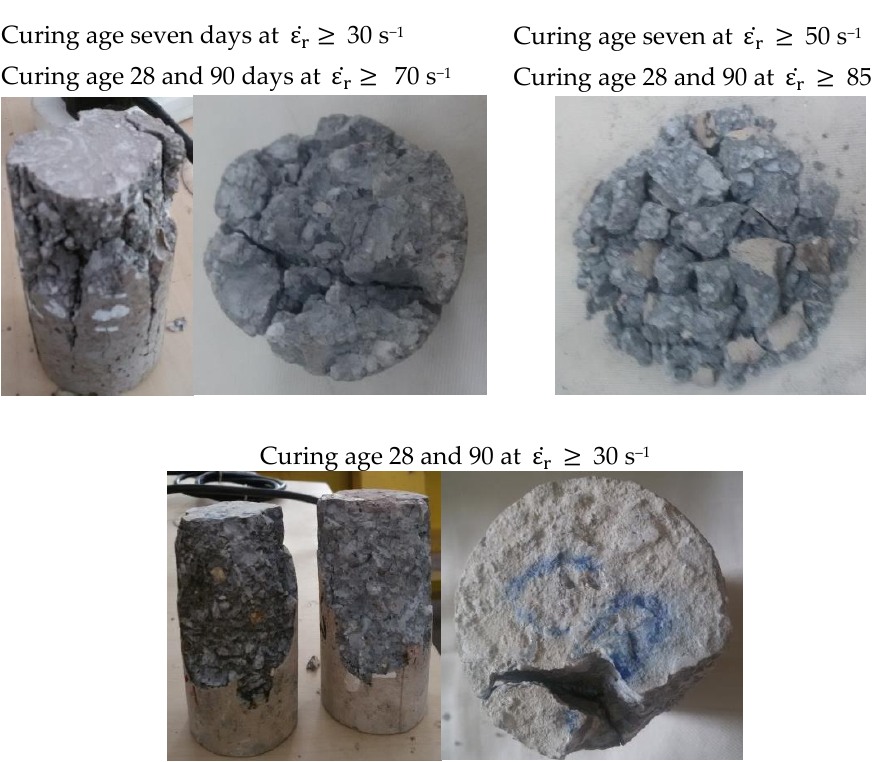
Figure 10. Effect of curing age on the damage mode of PC and HVFANS concrete specimens at Figure 10. E ff ect of curing age on the damage mode of PC and HVFANS concrete specimens at di ff erent different curing ages. curing